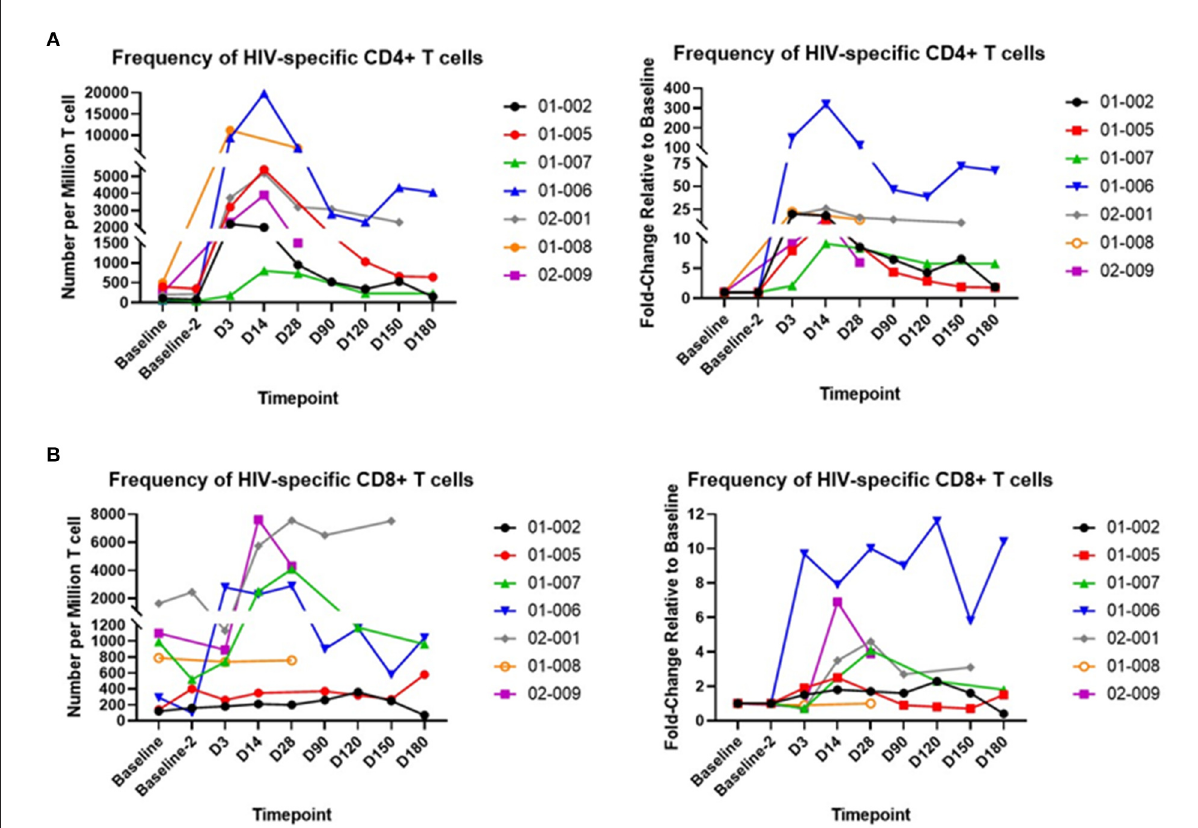
FIGURE4 Response of purified peripheral blood CD4 + and CD8 + T cells to HIV Gag peptide stimulation in vitro . (A) Left panel, frequencies of CD4T cells responding to Gag peptide, expressed as number per million CD3 + cells; right panel, fold change in numbers of Gag-specific CD4T cells relative to baseline (for D3–D28) and baseline-2 (for D90–D180). (B) Left panel, frequencies of CD8T cells responding to Gag peptide, expressed as number per million CD3 + cells; right panel, fold change in numbers of Gag-specific CD8T cells relative to baseline (for D3–D28) and baseline-2 (for D90–D180). Individual trial participants are indicated by a 5-digit identifier in the